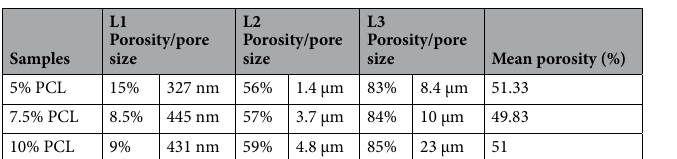
Table 2. Pore size and porosity (percentage) of each sample with different layers. L1: the deepest layer, L2: the middle layer, and L3: the most superficial layer.